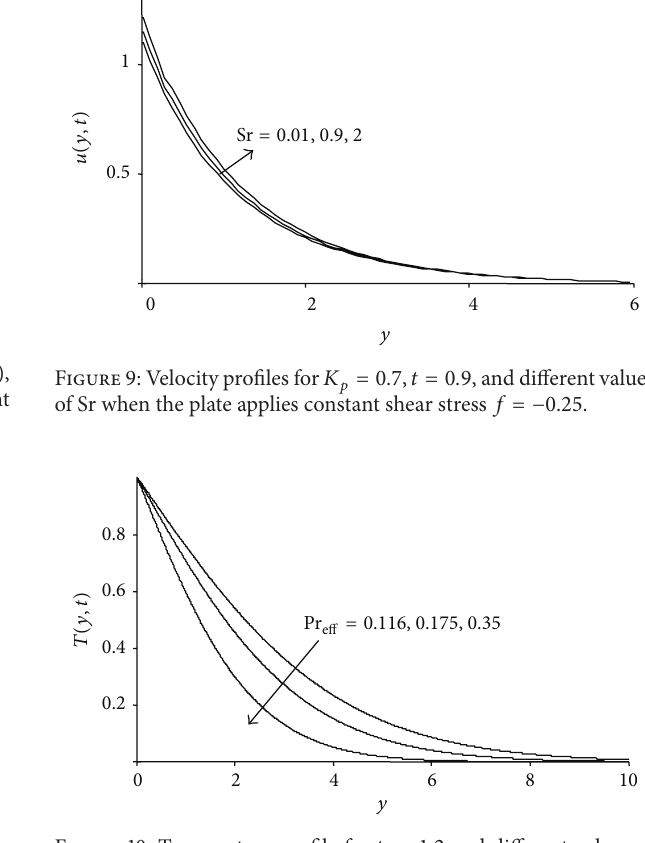
Figure 10: Temperature profile for 𝑡 = 1 . 2 and different values of Pr eff .